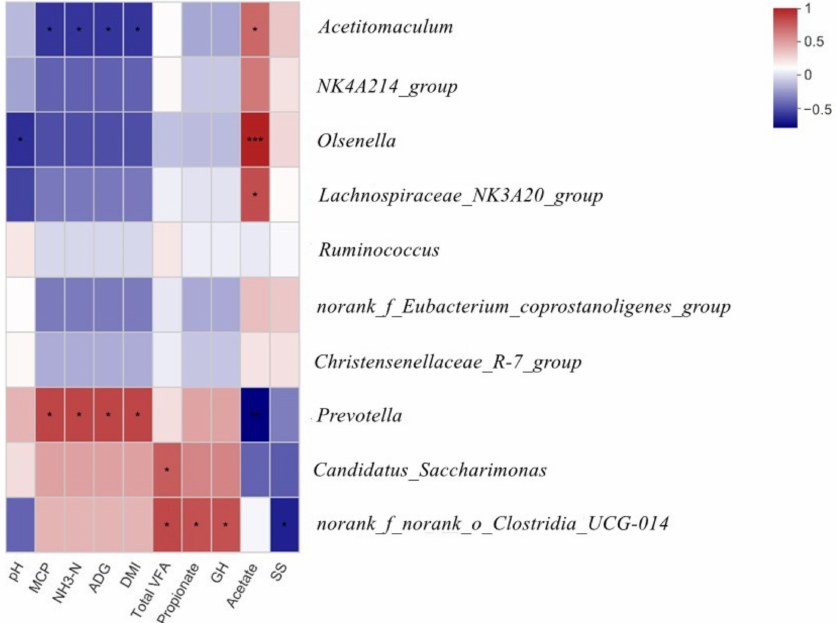
Figure 3. Heat map of the correlations among the top 10 bacterial genera and the parameters of rumen fermentation, blood serum index, and growth performance. Color intensity represents p -values of correlation, * p ≤ 0.05, *** p ≤